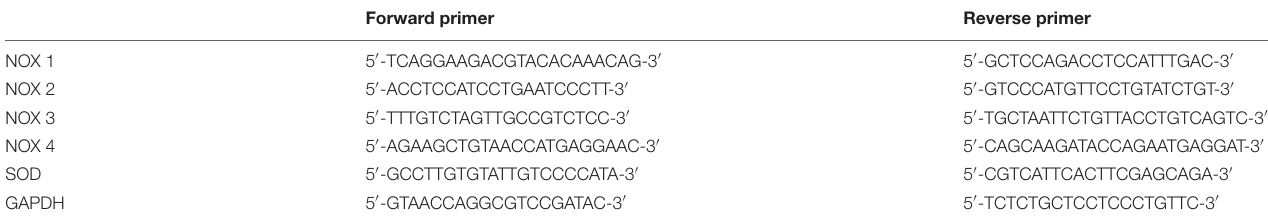
TABLE 1 | Forward and reverse primers used in qPCR experiments. Forward primer Reverse